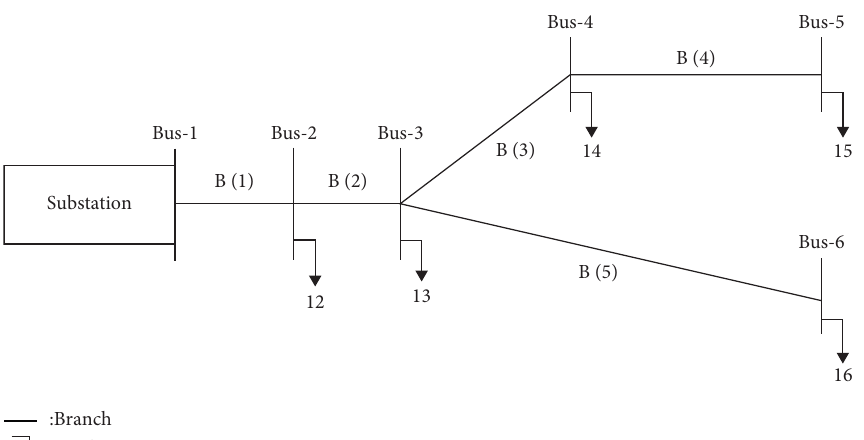
Figure 2: Six-bus balanced radial distribution